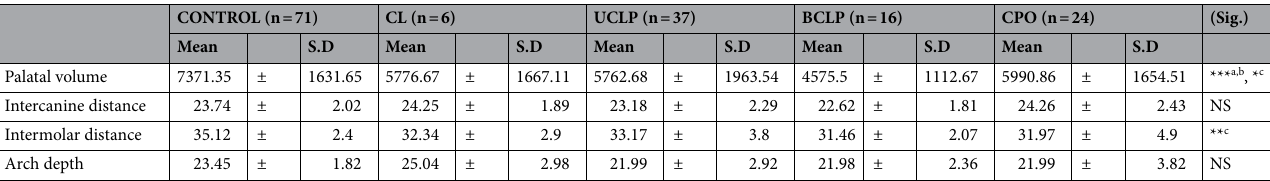
Table 1. Comparison of three-dimensional digital model measurements between groups. Sig. Statistical significance, NS not significant. * p ≤ 0.05; ** p ≤ 0.01; *** p ≤ 0.001; a Controls versus UCLP. b Controls versus BCLP. c controls versus